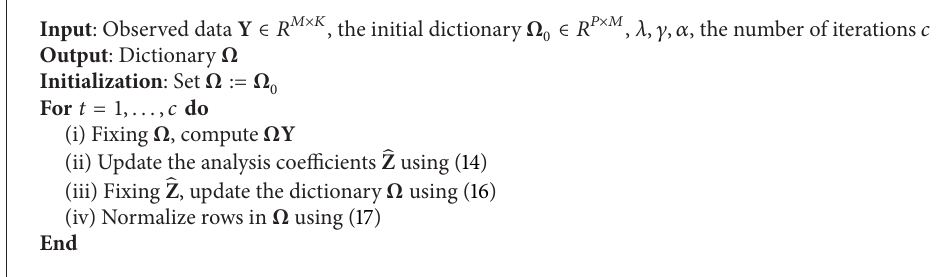
∈ 𝑅 𝑃×𝑀 , 𝜆, 𝛾,𝛼 , the number of iterations 𝑐 0